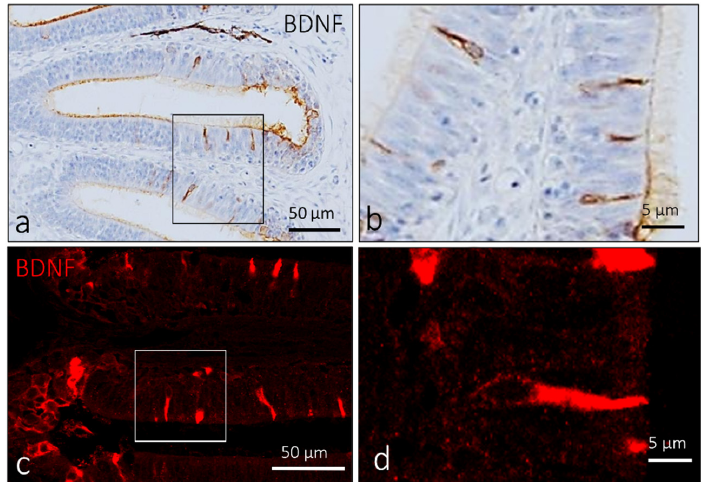
Figure 3. Olfactory lamellae of adult zebrafish, dorsal view. Immunohistochemical detection of BDNF: ( a , b ) peroxidase method, ( c , d ) immunofluorescence method. ( a – d ) Elongated sensory cells in sensory segment of olfactory lamellae show immunoreactivity to BDNF. ( a , c ) Scale bar 50 µm. ( b , d ) Scale bar 5 µm.